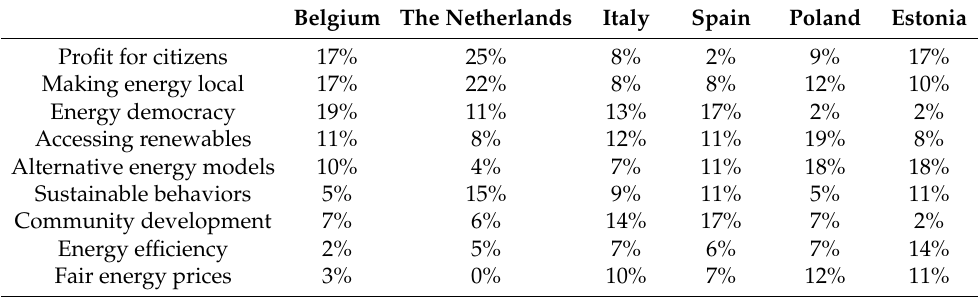
Table 1. CAIs’ main